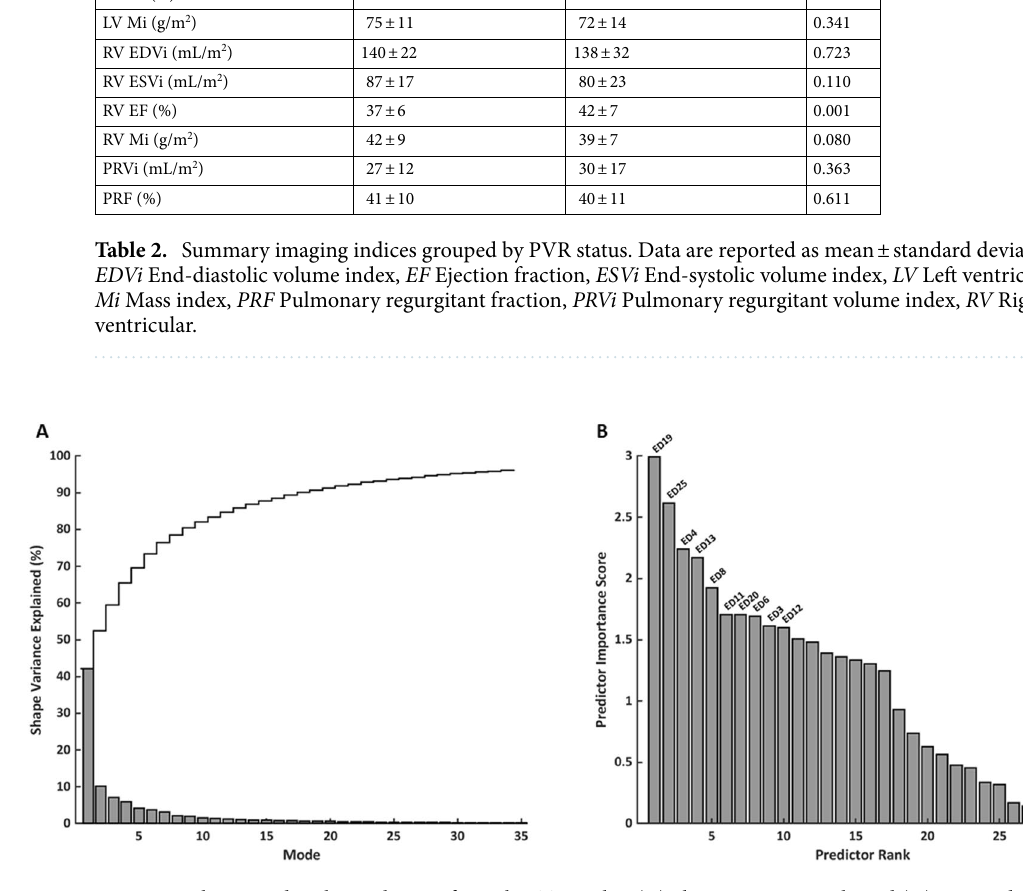
Figure 1. Shape mode subset selection from the rTOF atlas. ( A ) Shape variance explained (%) per mode (shaded bars) and cumulatively (solid line). ( B ) PVR status predictor rank and importance score for modes that explained greater than 95% of shape variation in the population. Labeled shape modes were retained for multivariate associations with PVR